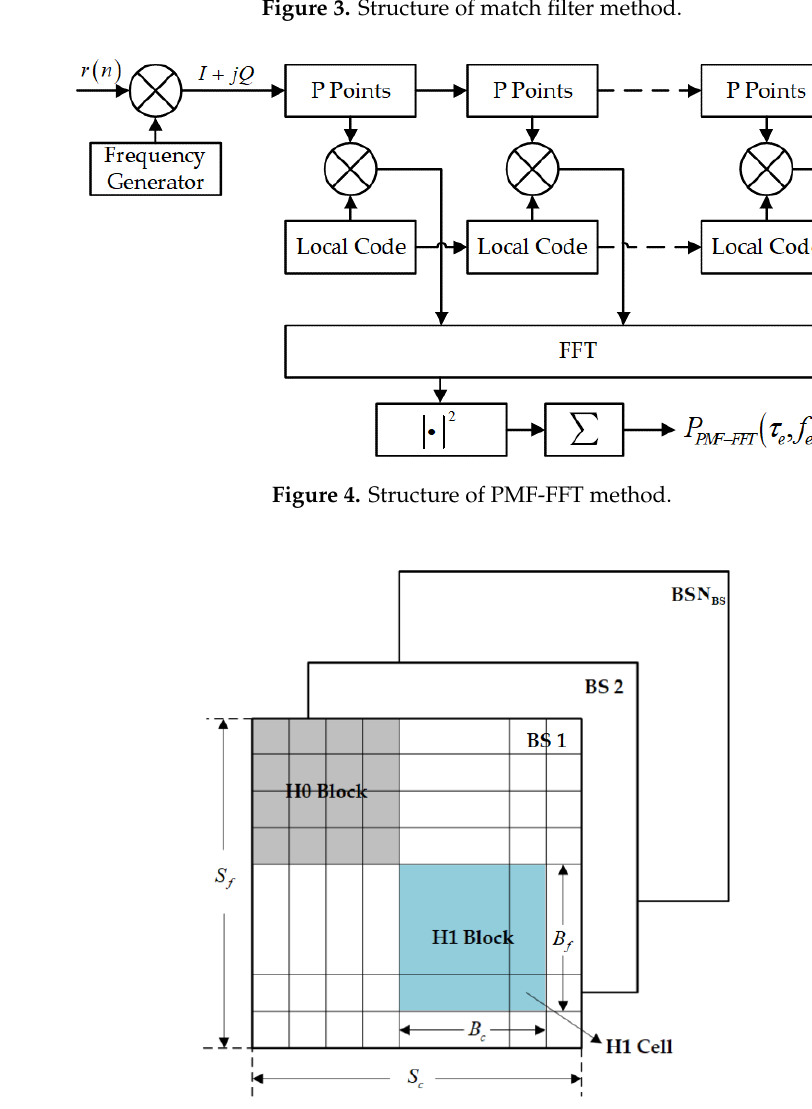
Figure 5. Search space.